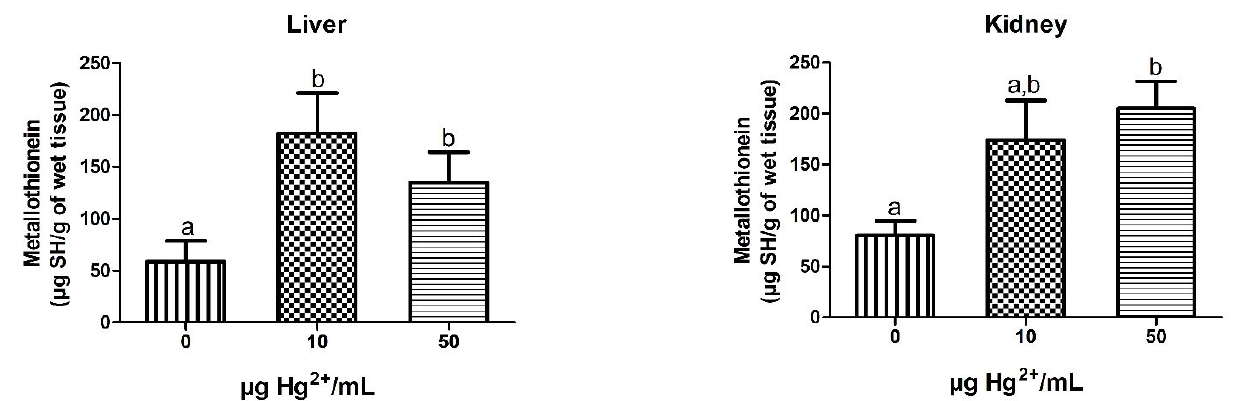
Figure 1. Hepatic and renal MT levels of dams exposed to different doses (0, 10, and 50 µ g Hg 2+ /mL) of HgCl2. The results are presented as mean ± SEM. Groups with the same letters have no statistically significant difference and groups with different letters differ statistically (Tukey’s multiple range test; p < 0.05). 0 = 0 µ g Hg 2+ /mL group (control group); 10 = 10 µ g Hg 2+ /mL group; 50 = 50 µ g Hg 2+ /mL group. Table 6. Metallothionein from different organs of pups’ rats exposed to different doses (0, 10, and 50 µ g Hg 2+ /mL) of HgCl 2 as described in Tables 1 and 3,